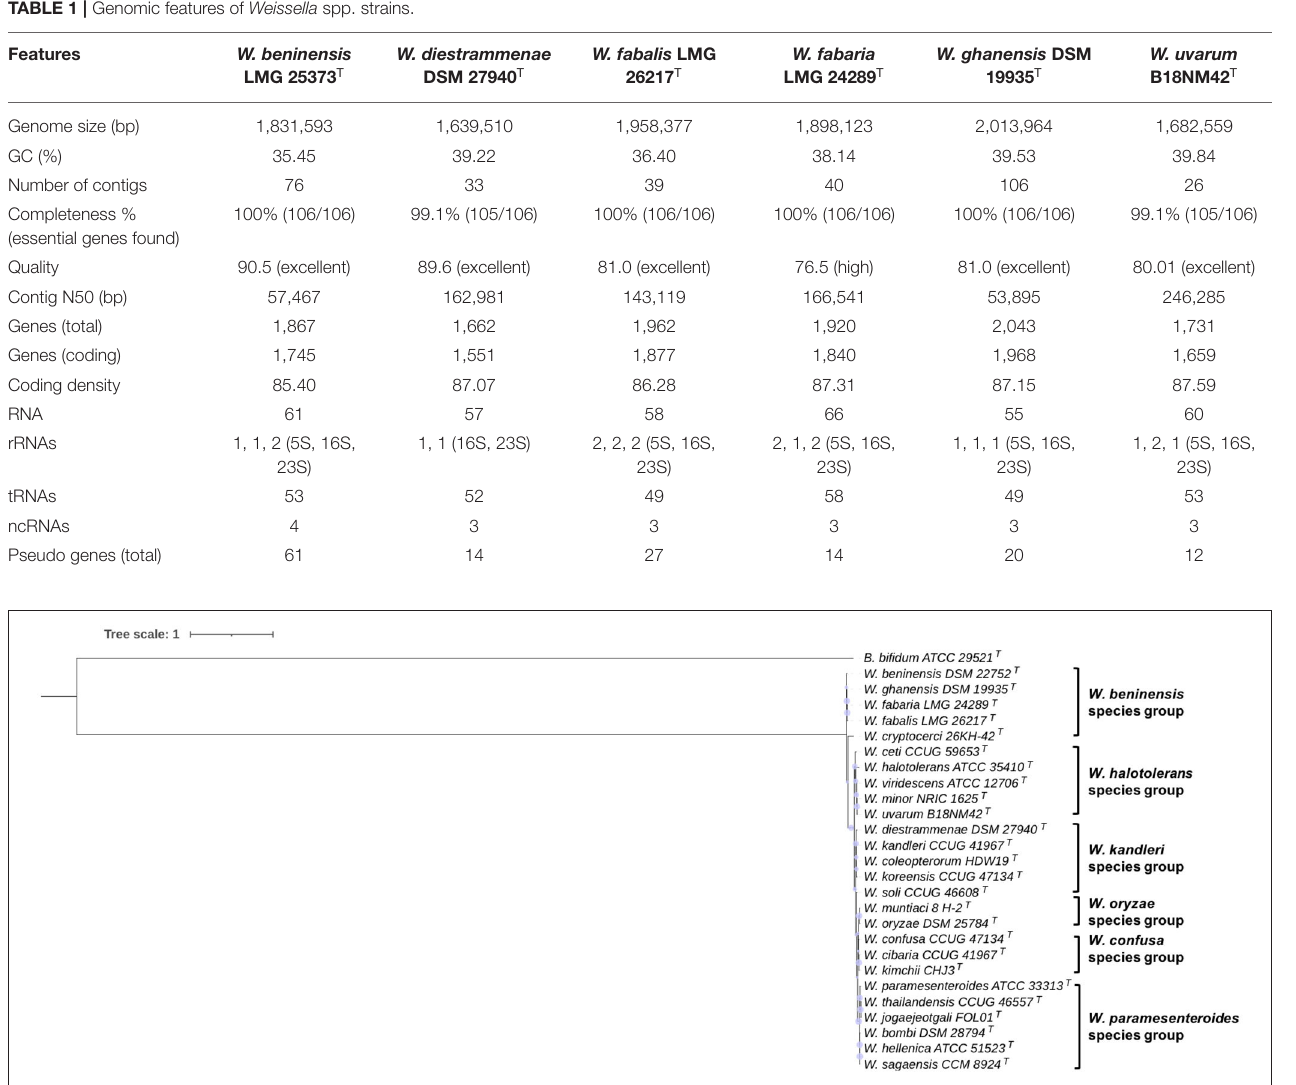
Figure 5 . The highest number of features was determined in the subsystem “protein metabolism,” followed by “carbohydrates and and W. jogaejeotgali type strains showed the highest total feature